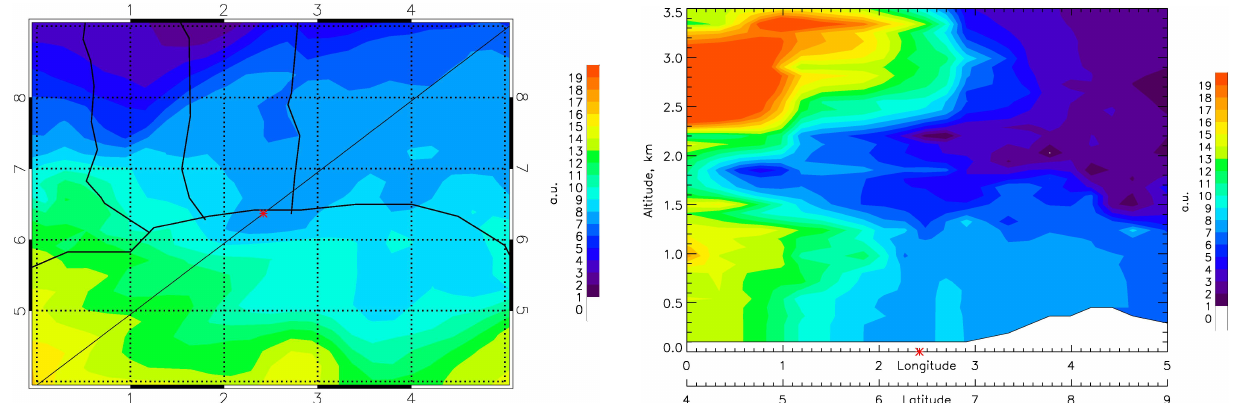
Fig. 10. Horizontal and vertical cross section of anthropogenic tracer mixing ratio in ppbv on August 19, 13 UTC from the 8km-anthro BOLAM simulation. Solid line on the 900 hPa cross section (top) indicates the position of the vertical cross section (bottom). Cotonou is indicated by the red asterisk. CO emissions > 0.5 µgm − 2 s − 1 in pink squares. 42 Fig. 11. Horizontal and vertical cross section of biomass burning tracer concentration in arbitrary units (see text) on August 19, 12 UTC from the 24km-bb BOLAM simulation. Solid line on the 900 hPa cross section (top) indicates the position of the vertical cross section (bottom). Cotonou is indicated by the red asterisk. 43